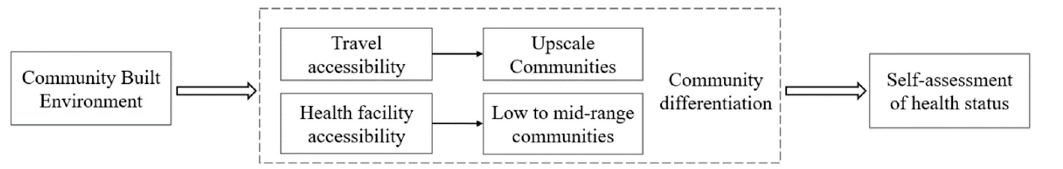
Figure 3. Community differences in the impact of a community-built environment on health status. For low-end communities, all built environment variables, except for population density, had a significant effect on residents’ health status, and the regression coefficients were higher than those of high-end communities. Combining the ICC with the between- group variance reduction ratio, it is clear that the self-rated health status of residents in low-end communities is more influenced by the built environment around the commu- nity. Because of the limited radius of their daily activities, the most significant association with health status is the built environment around the community in a small area [46].